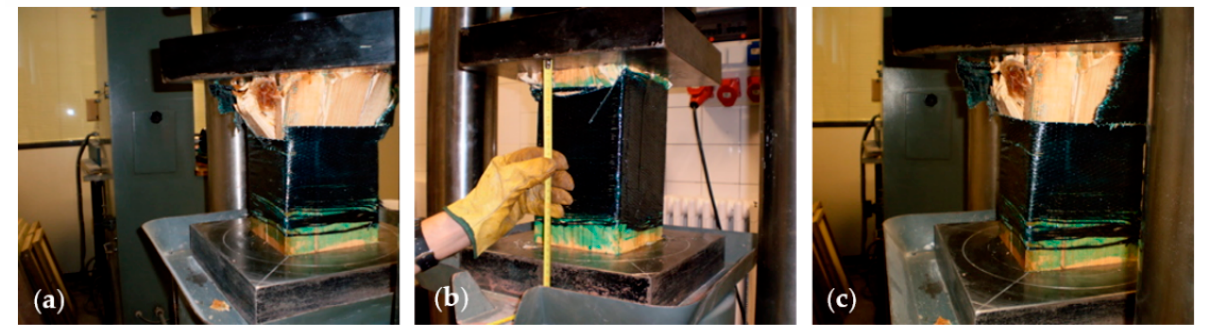
Figure 6. Breakage of reinforced pieces. ( a ) FC300, ( b ) FB280, and ( c ) FB600.